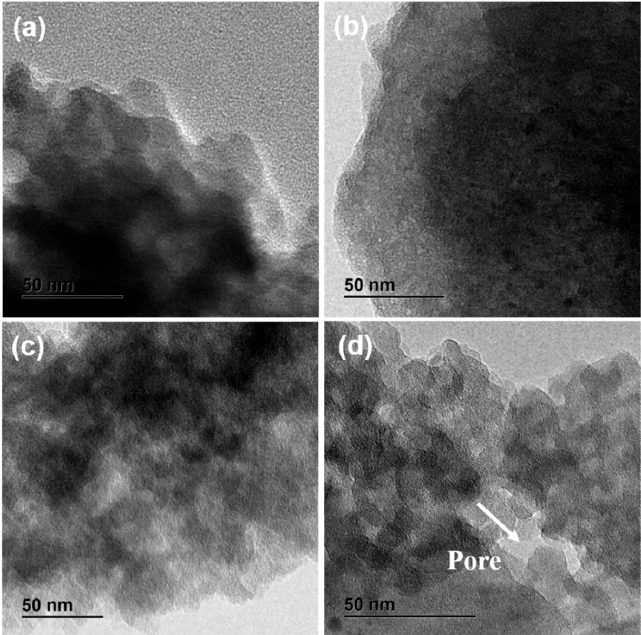
Figure 5. TEM images of the prepared silica ionogels: ( a ) IL 0, ( b ) IL 0.1, ( c ) IL 0.5, and ( d ) IL 3.0.